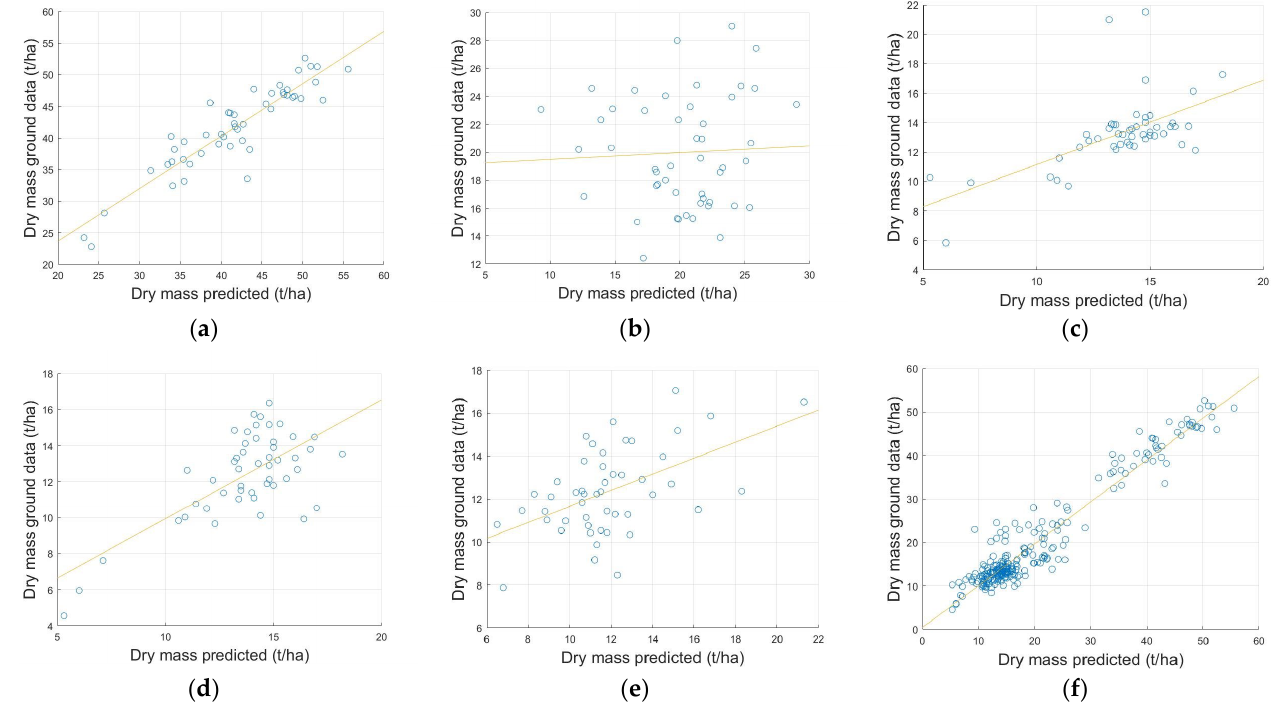
Figure 4. Scatter plots of the predicted dry mass against ground data. ( a ) D 1 (R 2 = 0.831), ( b ) D 2 (R 2 = 0.002), ( c ) D 3 (R 2 = 0.350), ( d ) D 4 (R 2 = 0.485), ( e ) D 5 (R 2 = 0.267), ( f ) all data (R 2 = 0.923). (R 2 = 0.002), ( c ) D 2 = 0.350), ( d ) D 2 = 0.485), ( e ) D 2 = 0.267), ( f ) all data (R 2 = 0.923). 3 (R 4 (R 5 (R